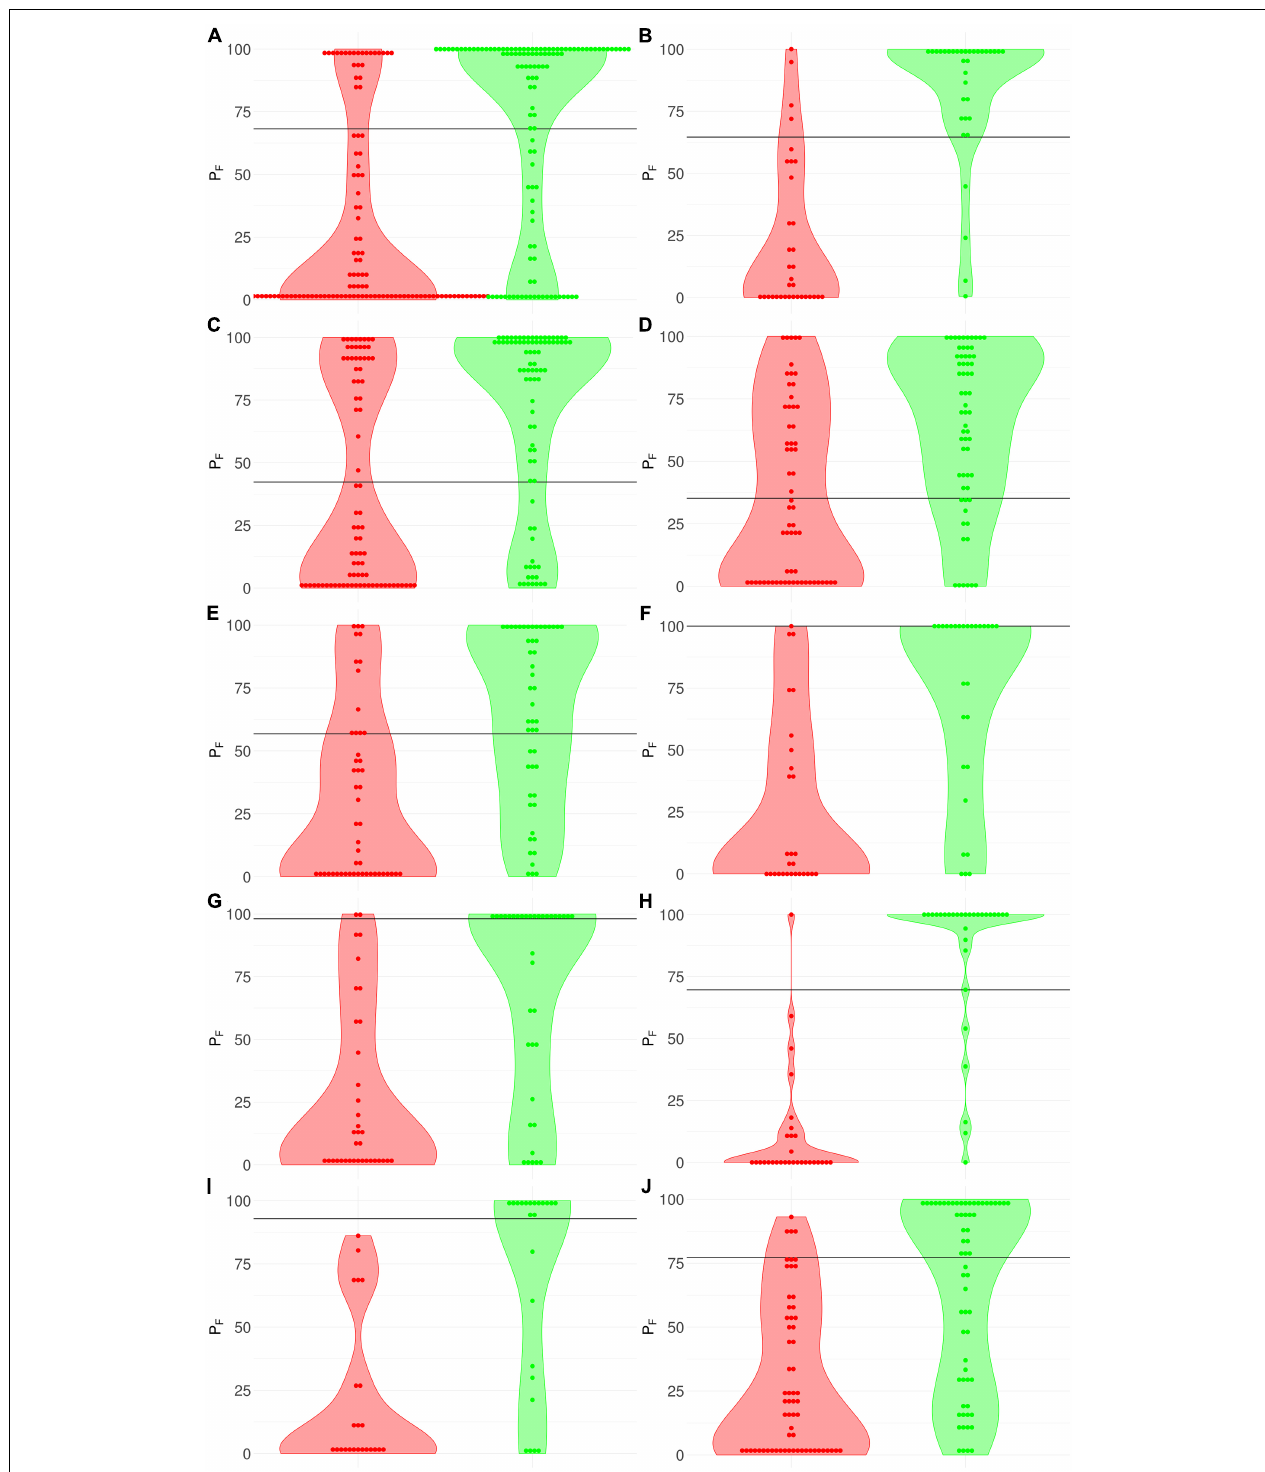
FIGURE 3 | Distribution (violin plots together with each instance showed as a red/green dot) of FloWPS predictions ( P F ) for patients without (red plots and dots) and with (green plots and dots) positive clinical response to chemotherapy treatment. For FloWPS, core marker genes and p = 0.90 settings were used. Black horizontal line shows the discrimination threshold ( τ ) between responders and non-responders for each classifier. Panels represent different data sources, (A) GSE25066; (B) GSE41998; (C) GSE9782; (D) GSE39754; (E) GSE68871; (F) GSE55134; (G) TARGET-50; (H) TARGET-10; (I) and (J) : TARGET-20 with and without busulfan and cyclophosphamide,